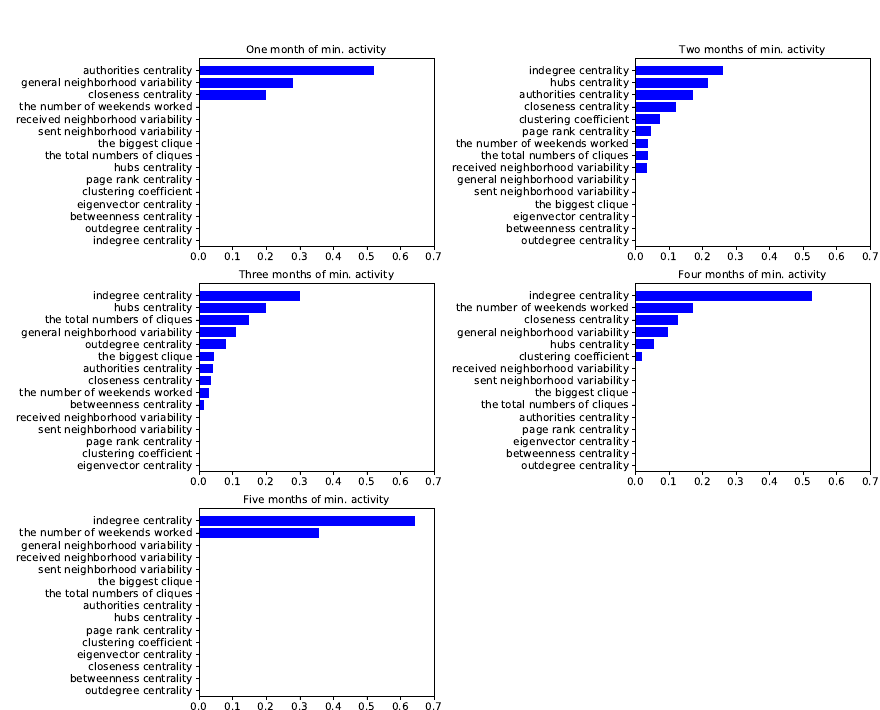
Figure A7. Features importance (Gini importance) for the Decision Tree which uses the full set of features for the Enron dataset with two levels of the hierarchy.